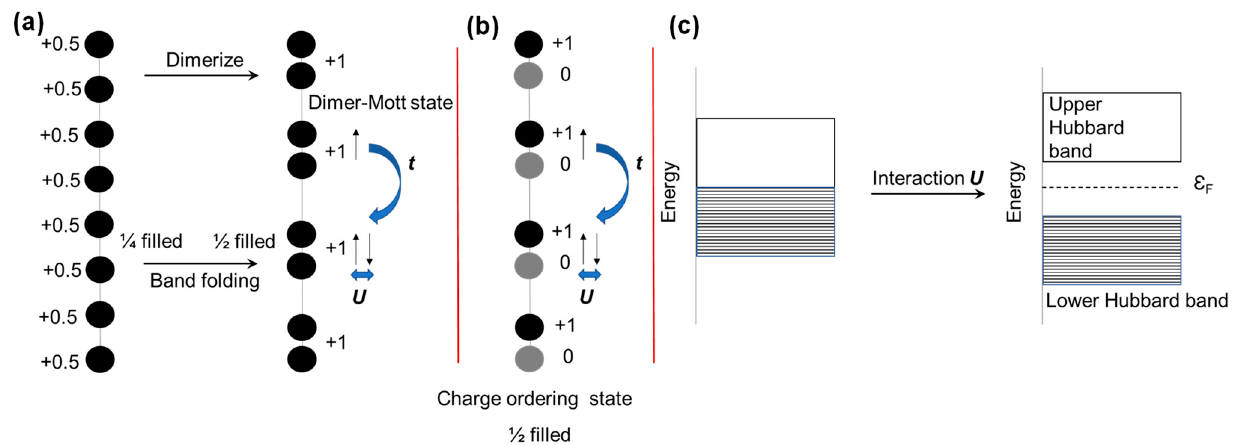
Figure 3. Schematic drawing of possible mechanisms to account for the non-metallic behaviors of compound 1 : the formation of a ( a ) dimer-Mott state, ( b ) a charge-ordering state, or ( c ) formation of upper Hubbard band and lower Hubbard band in the Mott-Hubbard insulators.